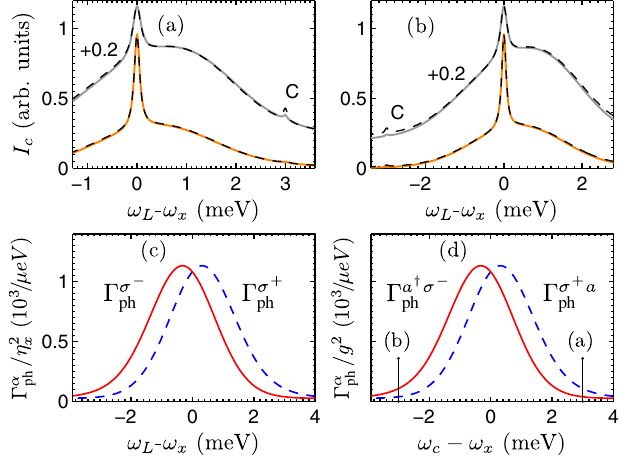
and g 2 ; the two x